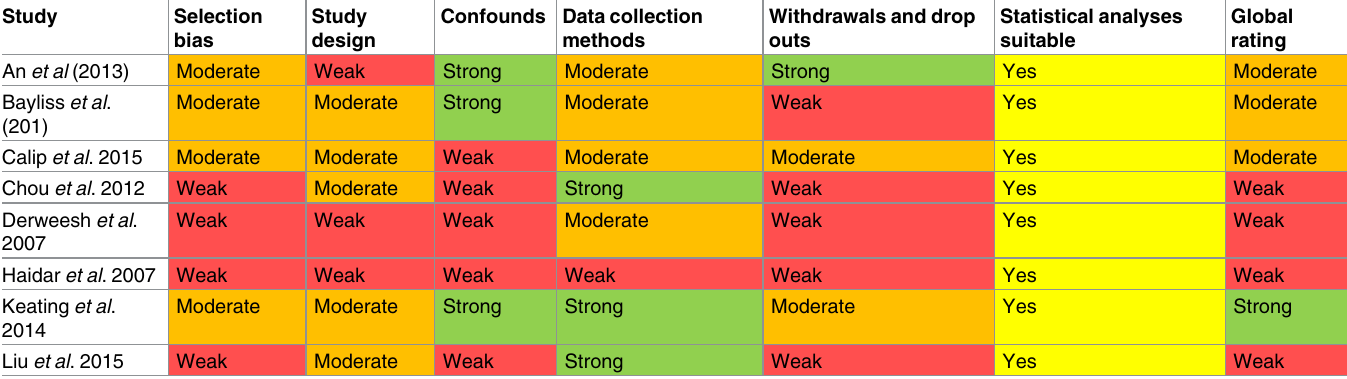
Table 5. Quality assessment of included